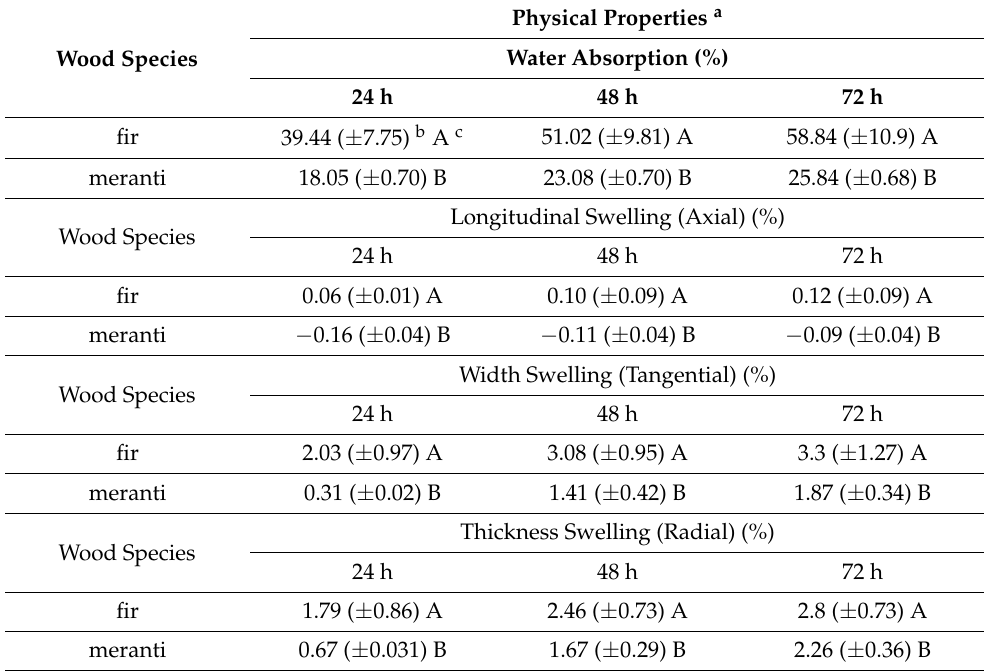
Table 1. Physical properties of fir and meranti wood.